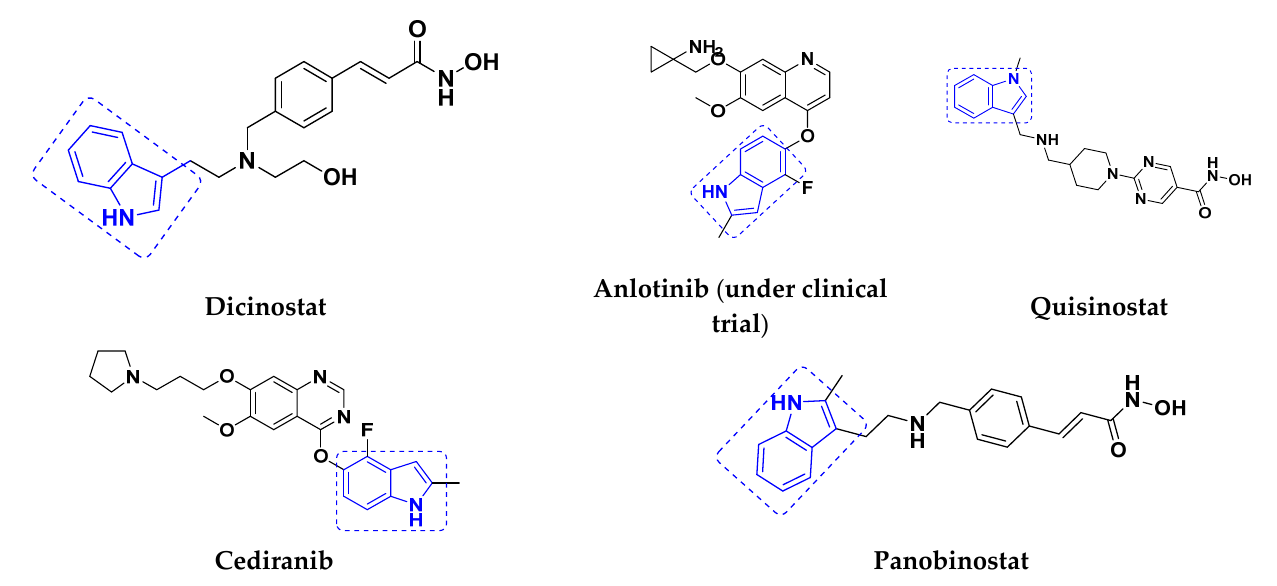
Figure 21. FDA approved/clinical trial drugs with indole hybrids. Table 19. Current status of indole ‐ based hybrids that are approved or/ ‐ under clinical trials.